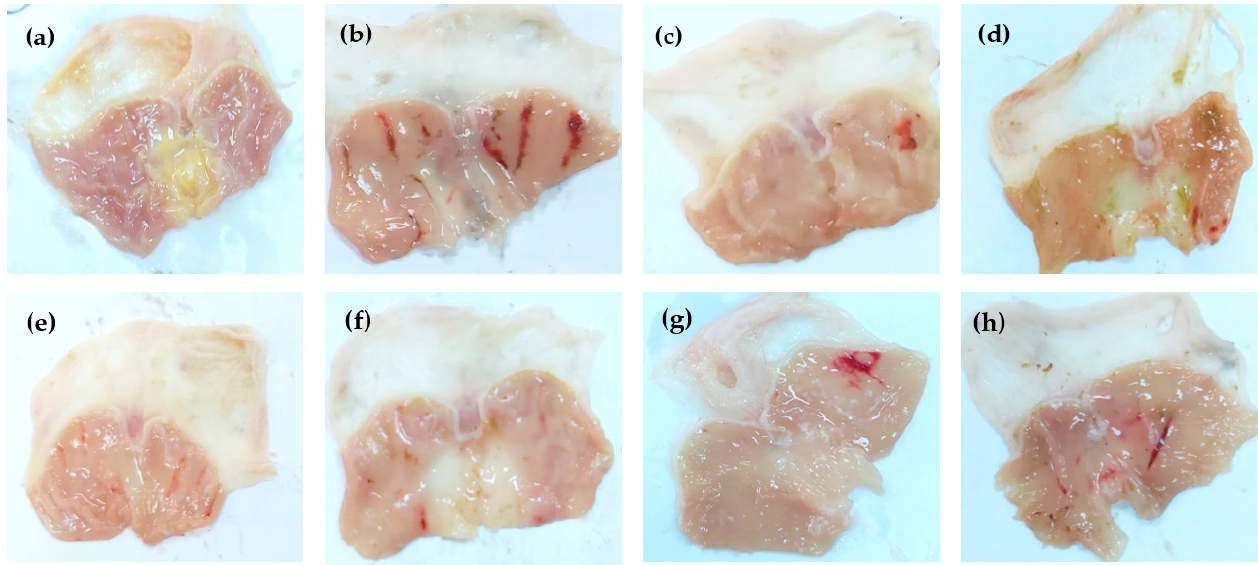
Figure 2. Gross appearance of gastric mucosa of rats treated with; saline ( a ), ethanol 1 mL ( b ), ethanol + antodine 20 mg/kg ( c ), ethanol+ MeOH extract ( d ), ethanol+ n ‐ Hex extract ( e ), ethanol+ CHCl 3 extract ( f ), ethanol+ EtOAc extract ( g ), and ethanol+ ReAq extract ( h ), using an oral dose of 500 mg extract/kg.